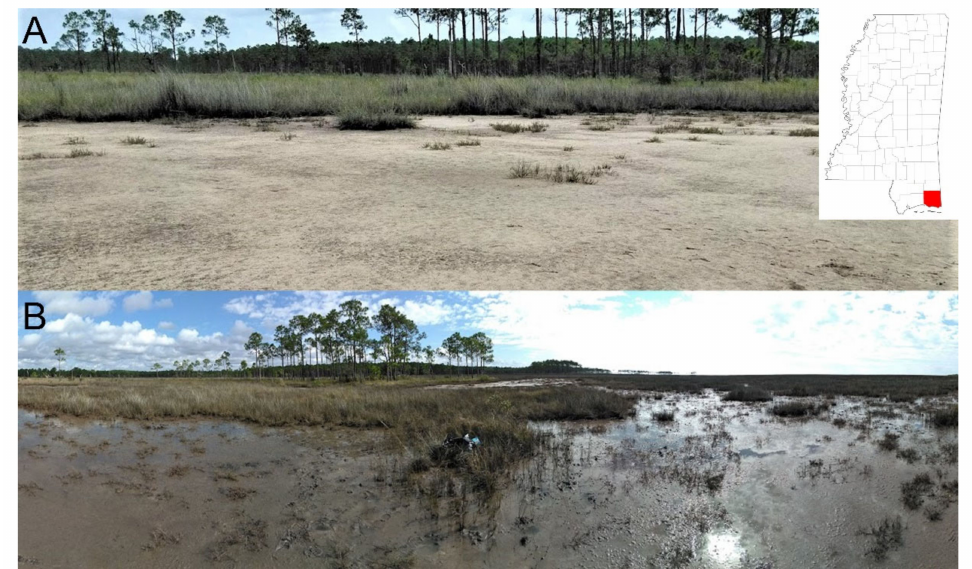
Figure 1. Saltpan wetland within the Grand Bay National Estuarine Research Reserve (GBNERR) on the Mississippi Gulf coast in June 2018 ( A ) under the desiccated state and in October 2018 ( B ) following a storm tide. The storm tide was generated by Tropical Storm Gordon, which made landfall east of Pascagoula, Mississippi on September 5,